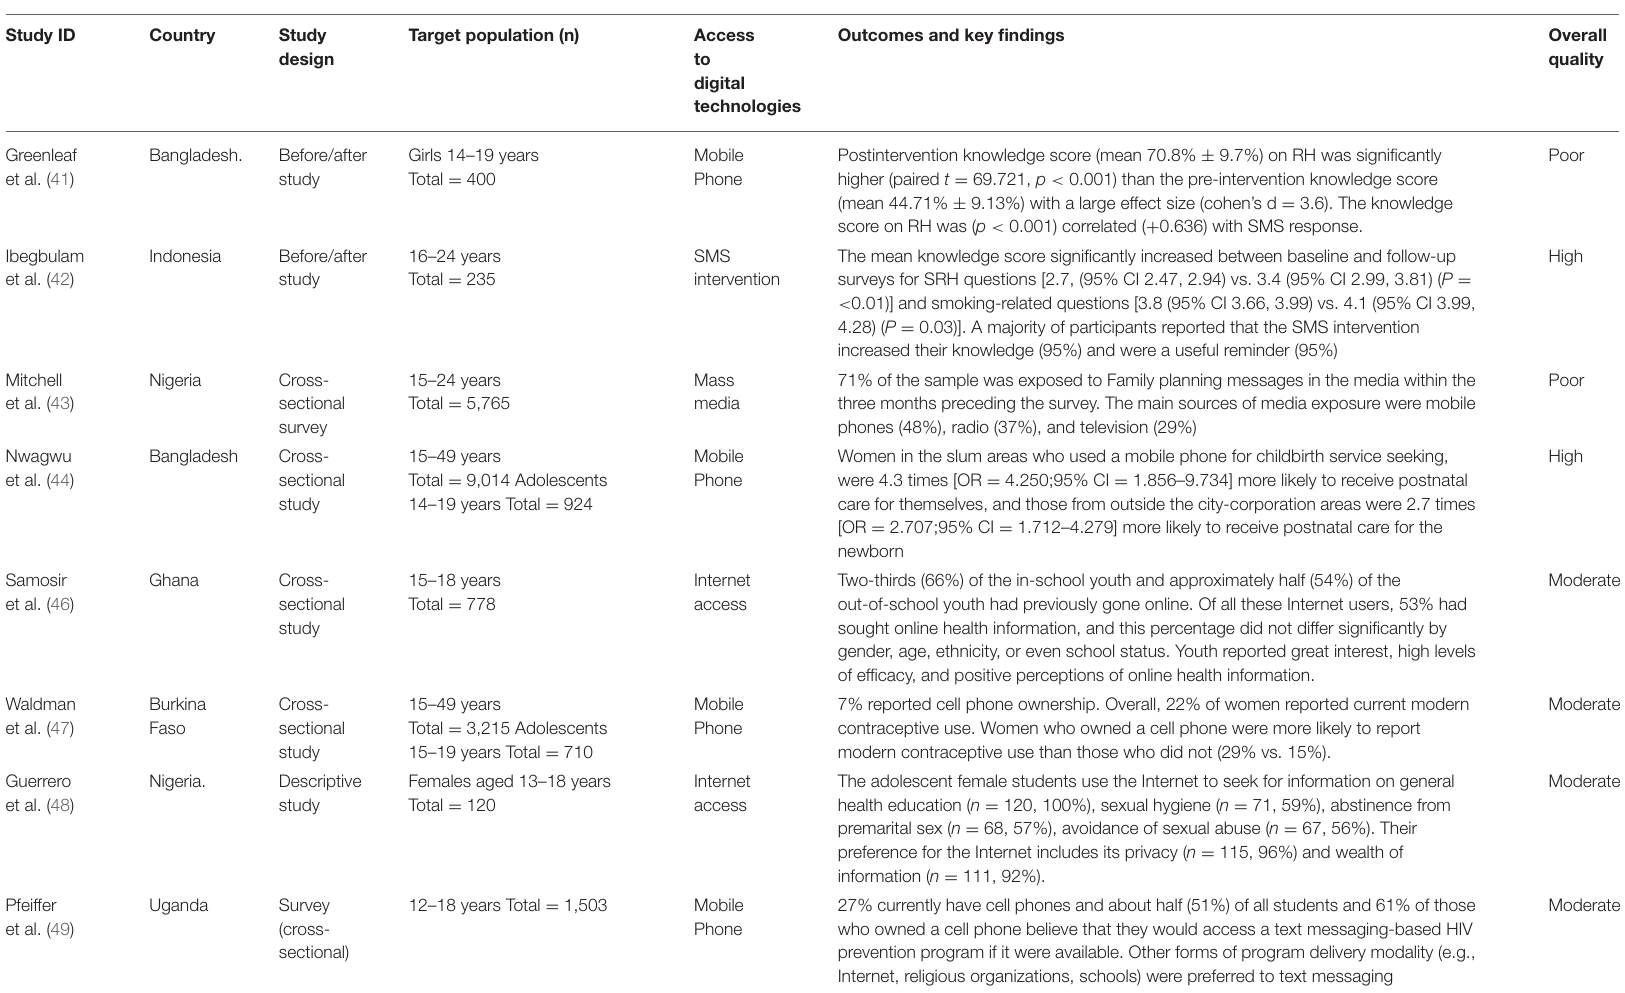
TABLE 2 | Study characteristics of observational and non-controlled before after